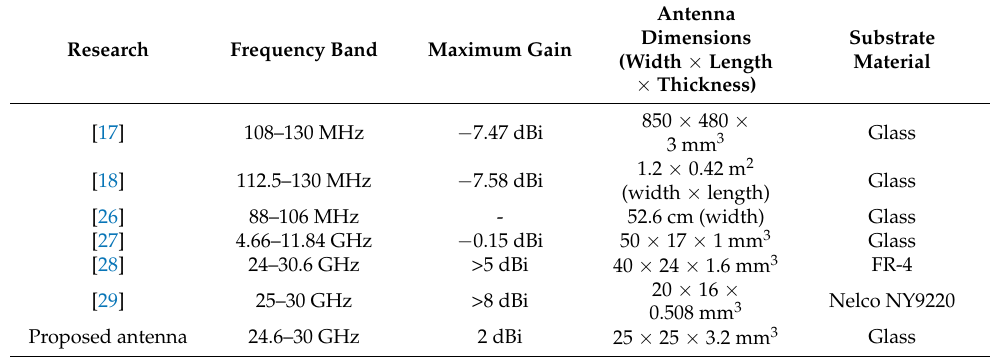
Figure 7. Measured and simulated radiation patterns of the proposed antenna: ( a ) zx -plane at 28 GHz; ( b ) zy -plane at 28 GHz; ( c ) zx -plane at 29 GHz; ( d ) zy -plane at 29 GHz. Table 2. Comparisons of antenna